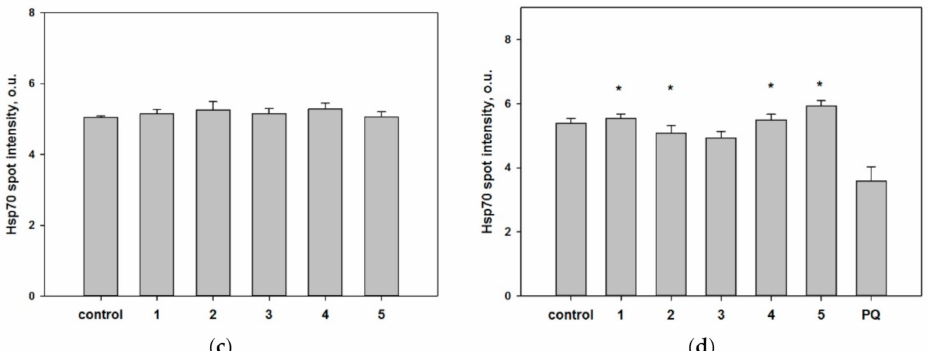
Figure 4. Effects of compounds 1 – 5 on Hsp70 level in Neuro-2a cells. ( a , c ) Neuro-2a cells were treated with compounds 1 – 5 at 10 μ M for 24 h. ( b , d ) Neuro-2a cells were treated with compounds 1 – 5 at 10 μ M for 1 h and then PQ was added for 24 h incubation. Each bar represents the mean ± SEM of three independent replicates. (*) indicates p < 0.05 versus PQ-treated cells. The difference between control and PQ-treated cells was considered significant ( p < 0.05).